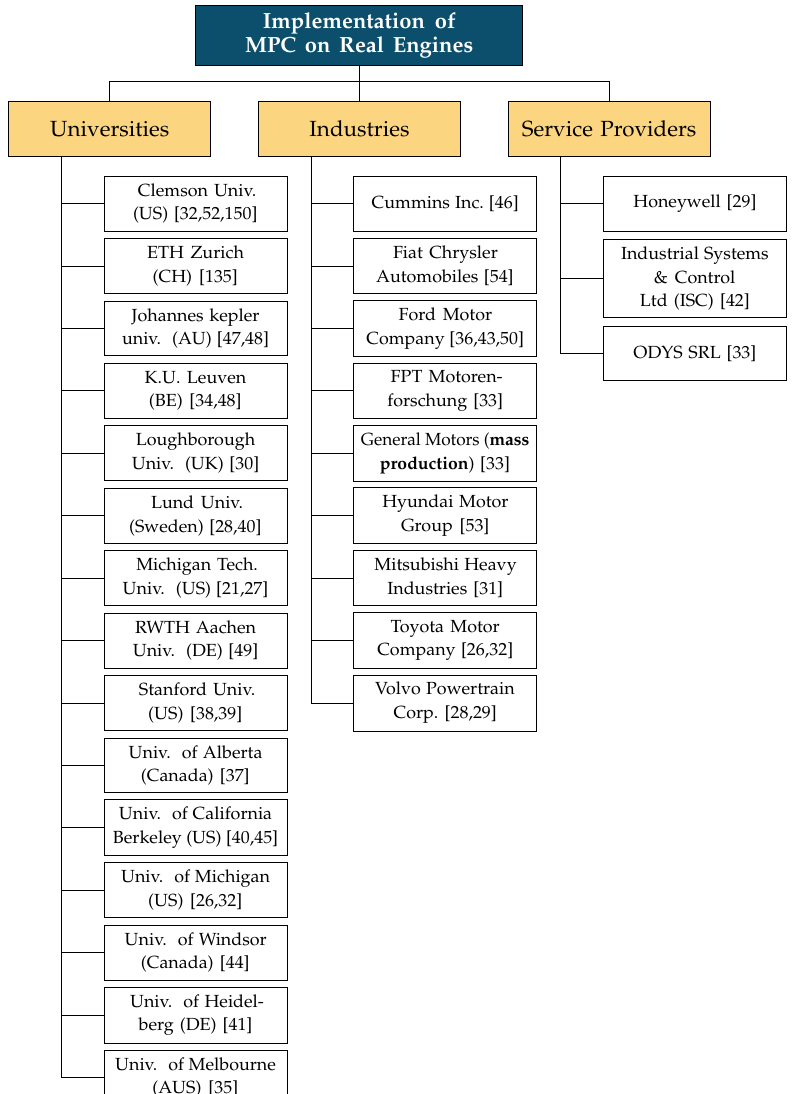
Figure 12. Successful experimental demonstrations of implementing MPC on